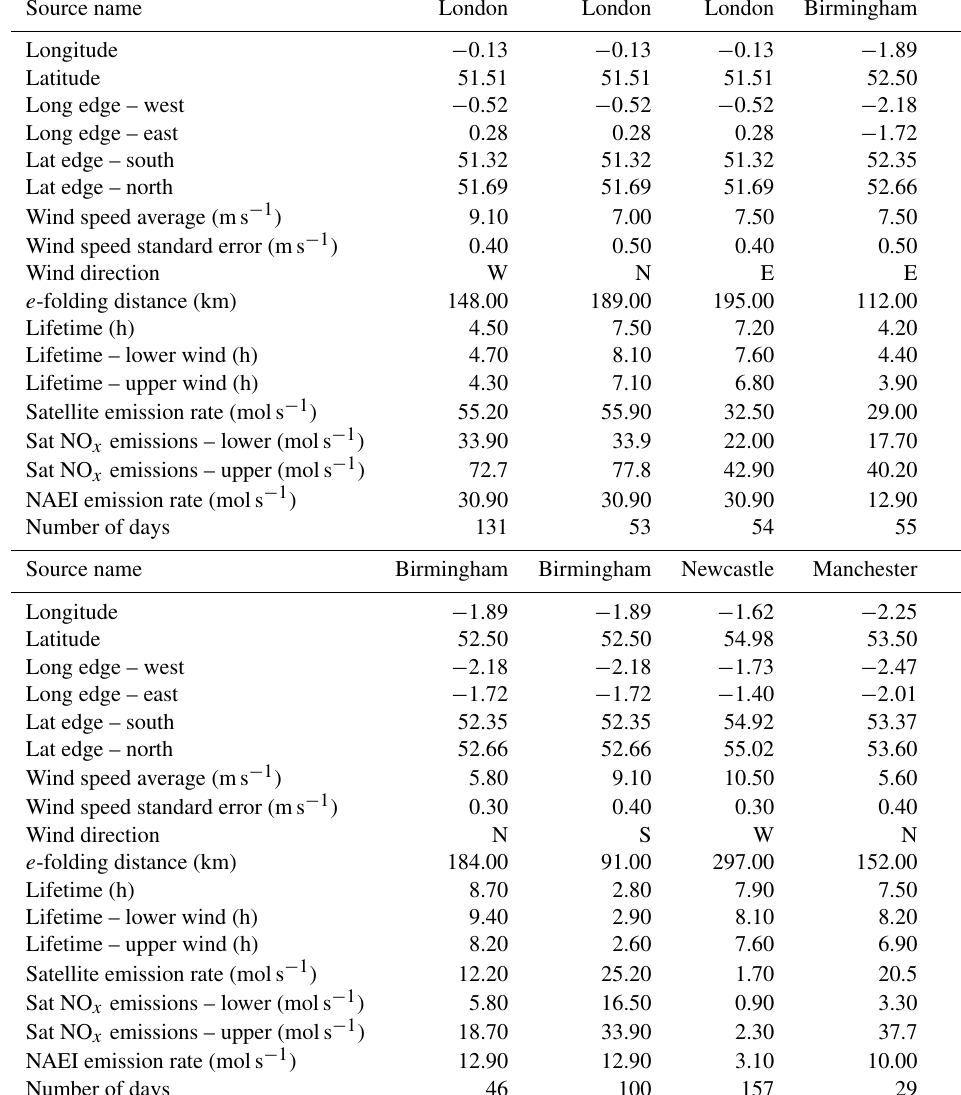
Table 1. List of top-down NO x (mols − 1 ) emission estimates for UK city sources under different wind directions. The Sat NO x emissions lower and upper ranges represent the emission flux ± the total